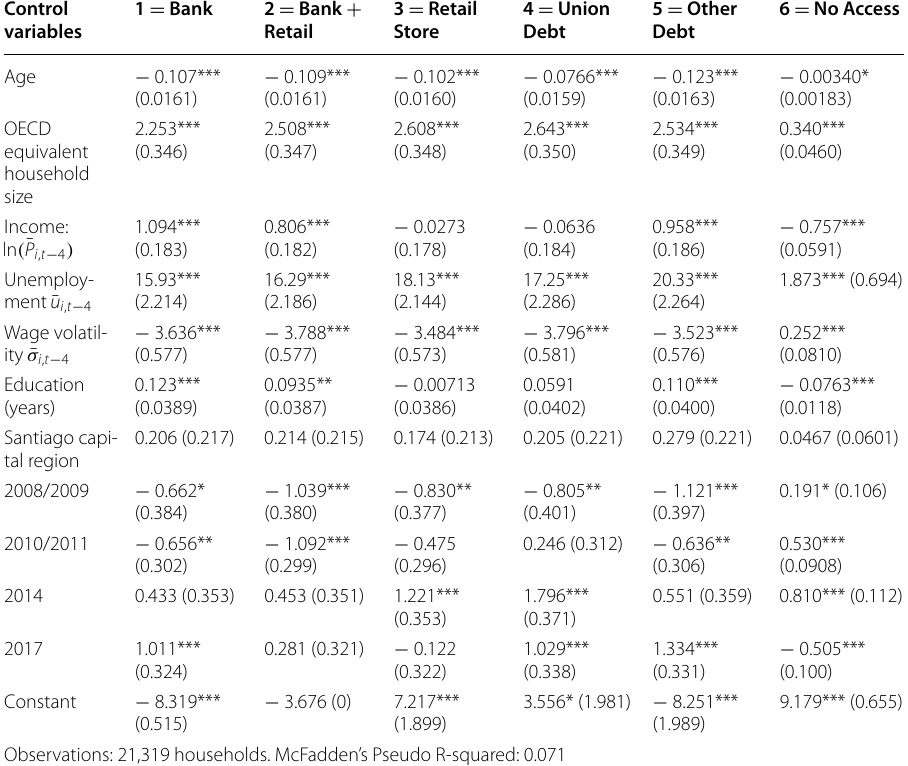
Robust Huber-White Standard-errors in () ***, **, *Denote 1%, 5%, 10% statistical significance